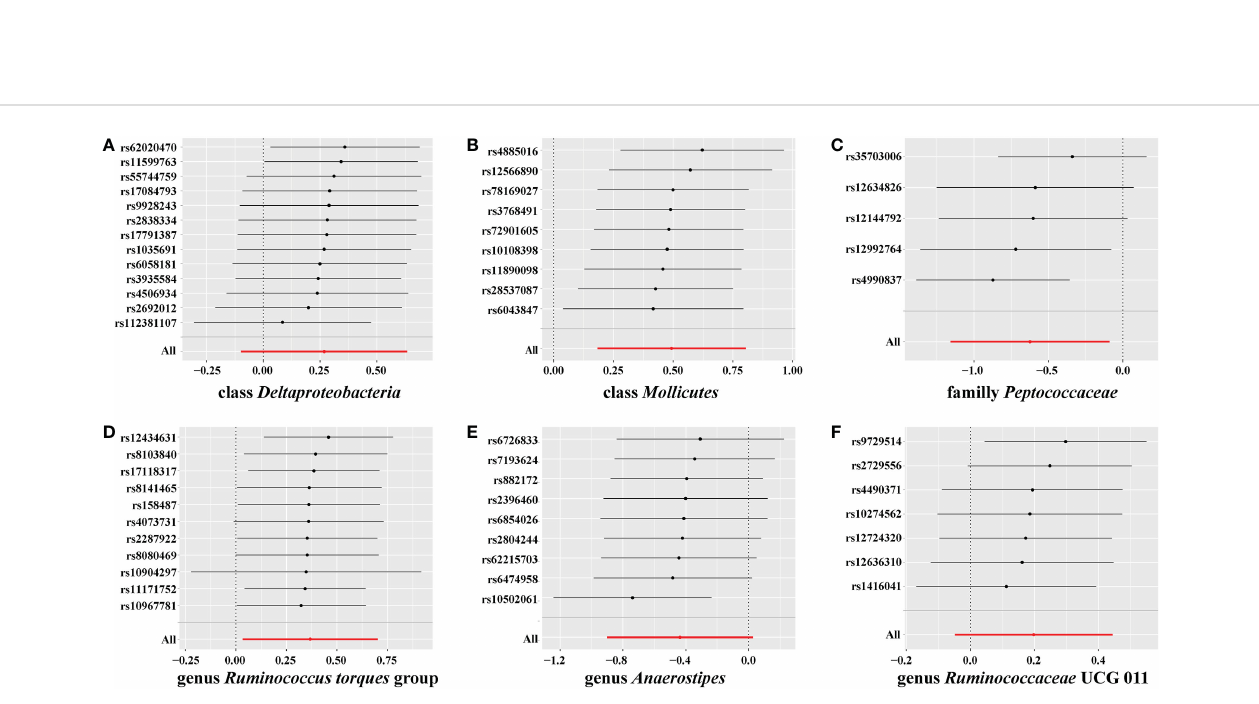
FIGURE 4 Leave-one-out analysis for gut microbiome on Graves ’ disease (GD). The sensitivity of the causal effect of different components of the gut microbiome on GD was analyzed through leave-one-out analysis in (A – F) . The error bar represents the 95% con fi dence interval with the method of inverse-variance weighting (IVW).